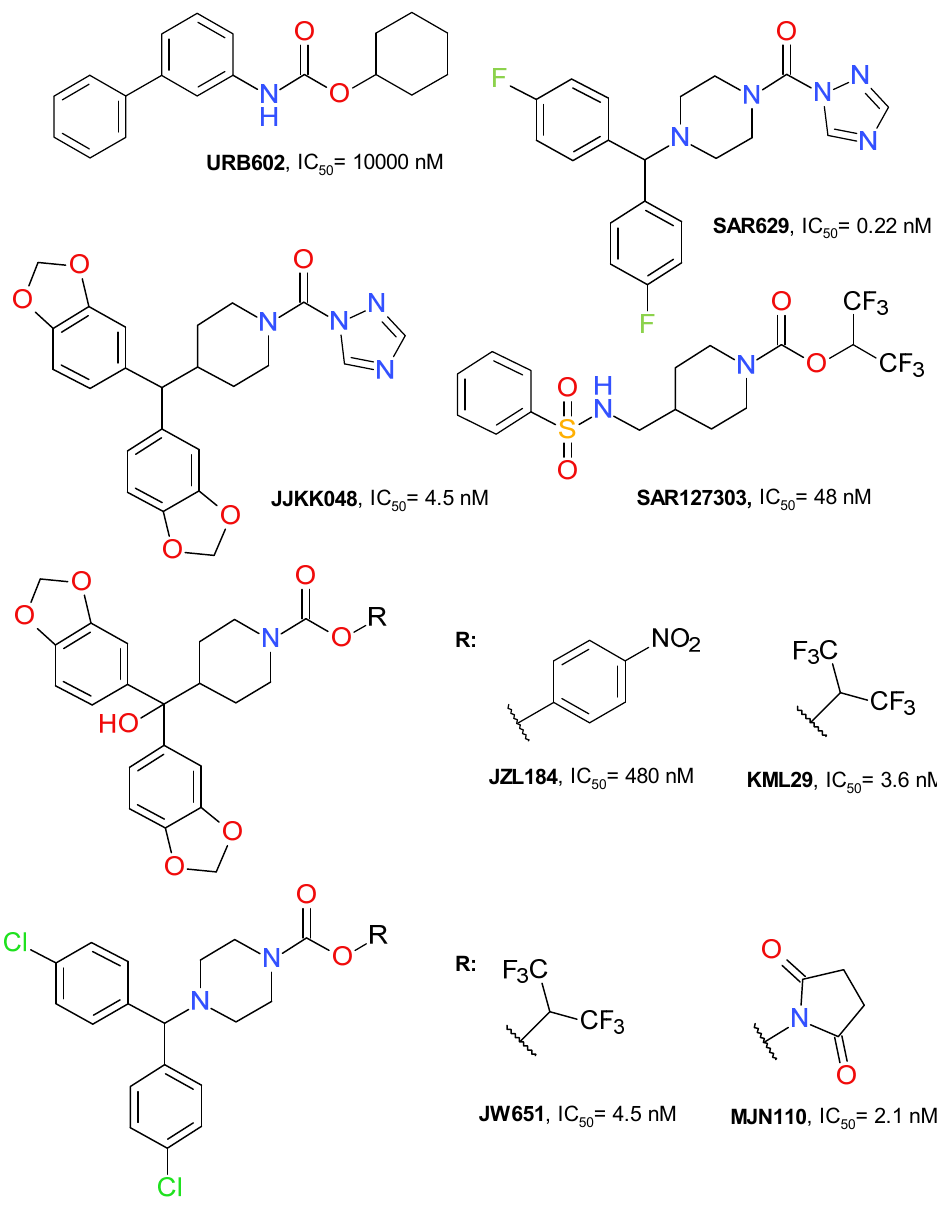
Figure 2. Representative irreversible MAGL